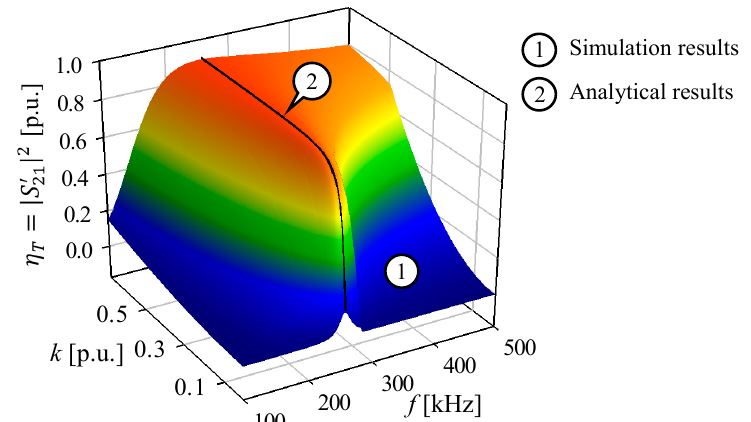
Figure 8. Power transfer efficiency of the matched asymmetric wireless power transmission system (1) and the trajectory of its maximum values (2) expressed in terms of the operating frequency ( f ) and coupling coefficient ( k ).